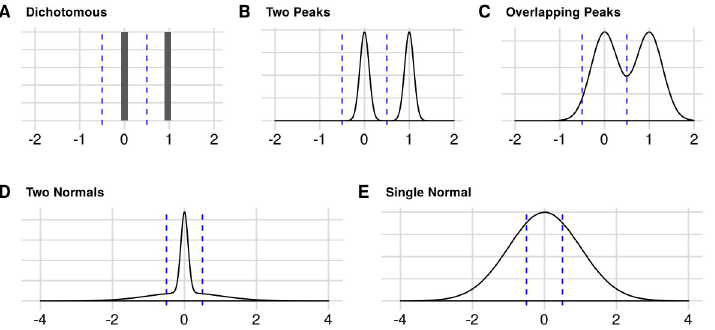
Fig 1. Effect size distributions used in the simulations. In the Dichotomous model ( A) , the density curve is replaced by a histogram, as effects sizes are strictly 0 or 1. The Two Peaks ( B ), Overlapping Peaks ( C ) and Two Normals ( D ) models are built as a mixture of two normal distributions with different means and/or SDs (see Methods for details). The weight parameter that regulates the mixture is 0.5 in the examples shown, leading to equal weights for both curves–in simulations, however, it varies according to the prevalence of true effects. For the Single Normal model ( E ), the weight parameter equals 1 and the standard deviation is used to control the prevalence. Dashed lines indicate the minimum effect size of interest (held fixed at 0.5 for all simulations): effects are considered true if their absolute size is larger than this